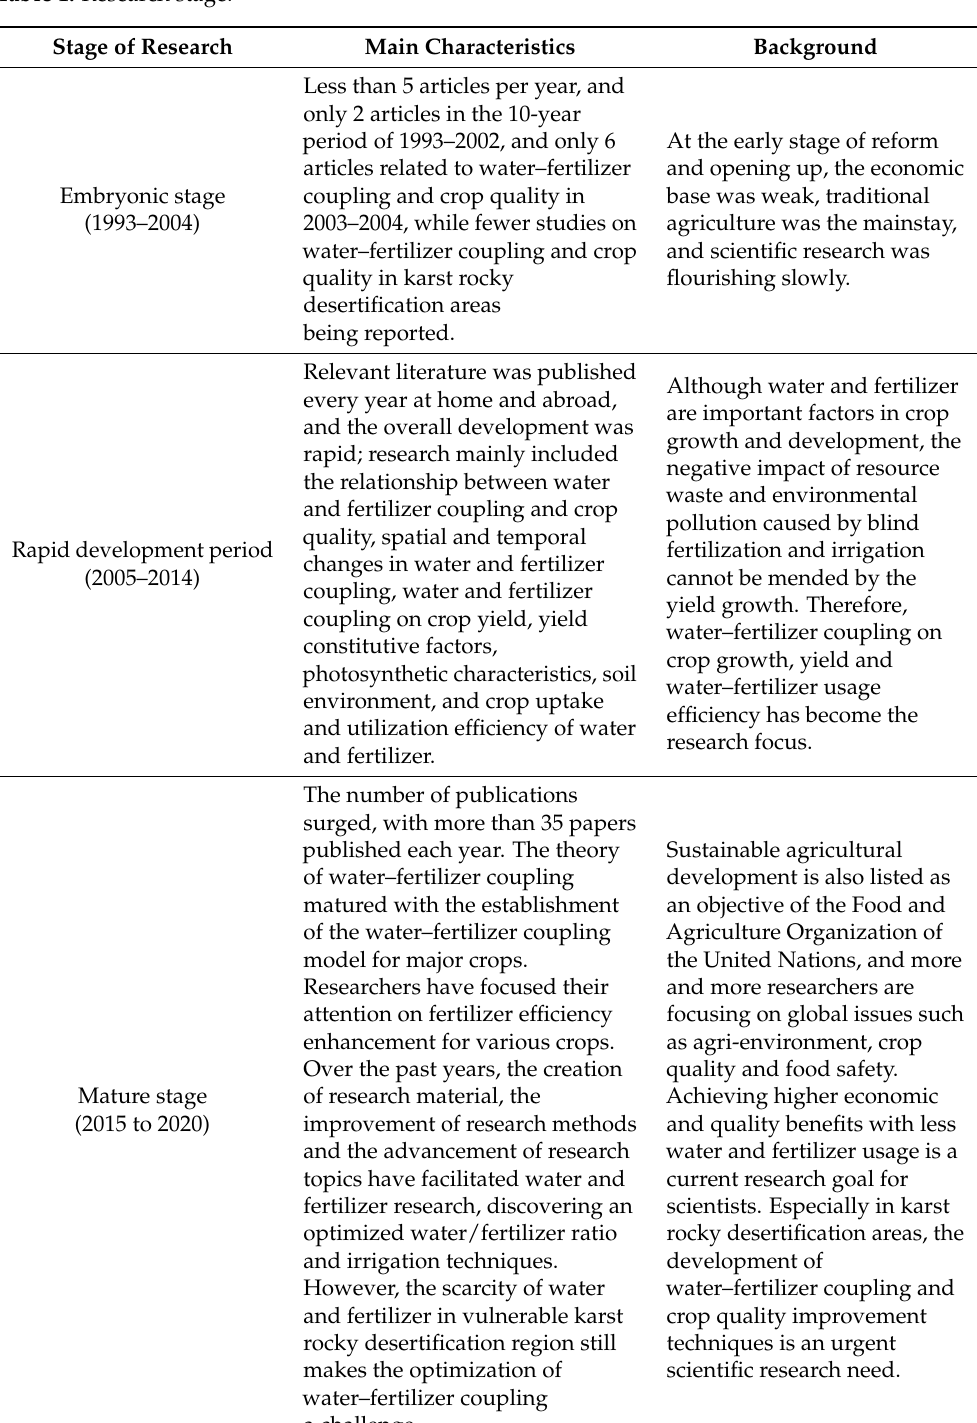
Table 1. Research